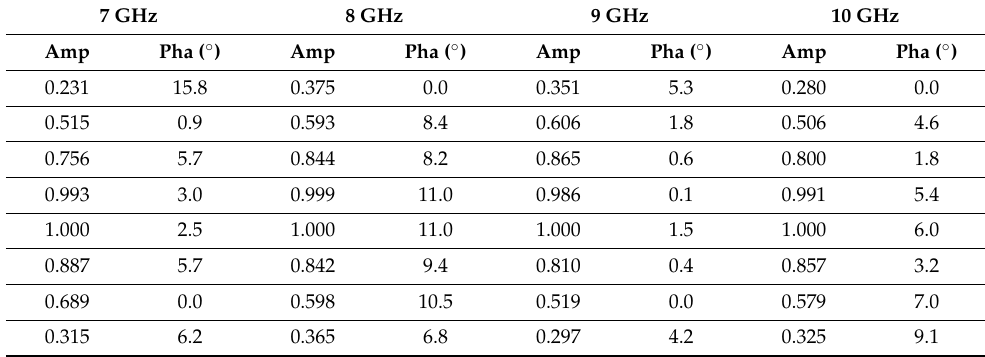
Table 5. Optimal weight vectors for Low PSLL optimization at four frequencies.